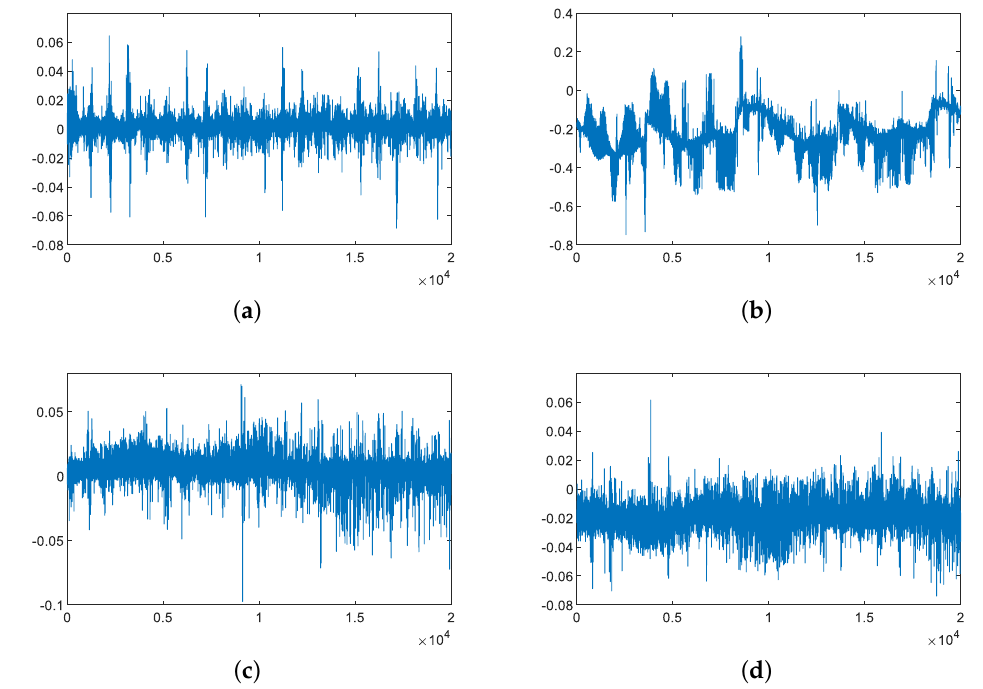
Figure 9. Vibration signals acquired in the following fault conditions: ( a ) Healthy state; ( b ) Pitting in Sun gear 1; ( c ) Broken tooth in Sun gear 1; and ( d ) Cracking in Planetary gear 2.